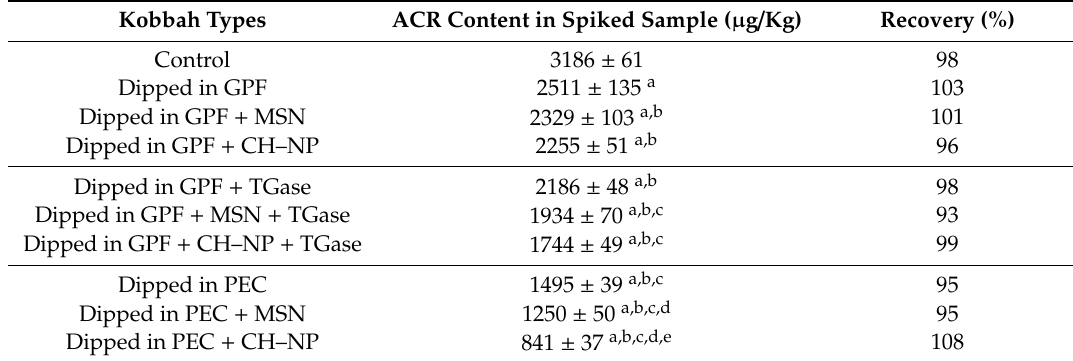
Table 2. Acrylamide content (ACR) recovery in all kobbah samples (in each sample 150 µ g / L of ACR standard were